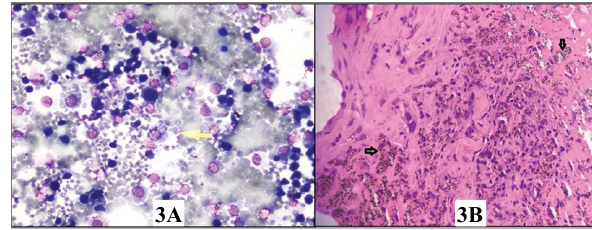
Figure 3: Cytopathology and Histopathology in Diffuse Alveolar Hemorrhage in the same patient. 3A: BAL cytology reveals plenty of RBC's and hemosiderin-laden macrophage. 3B: Bronchoscopic lung biopsy shows mild fibrosis with numerous siderophages filling the alveolar space